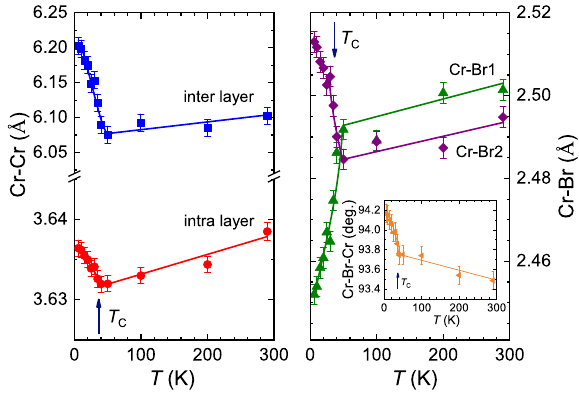
Fig. 3 The evolution of interatomic distances and angles as a function of temperature. The temperature dependences of the interatomic distances and angles in CrBr 3 . The lines are guides to eyes only.